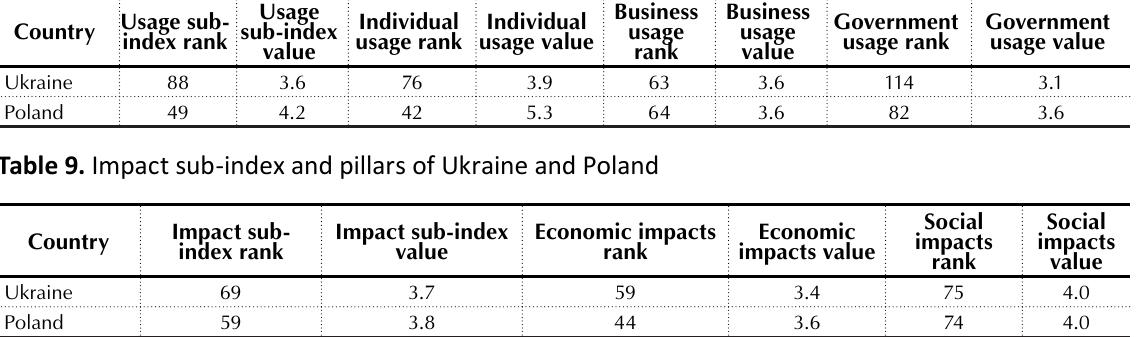
Table 10. Ukraine’s position according to the United Nations e-Government Survey 2016